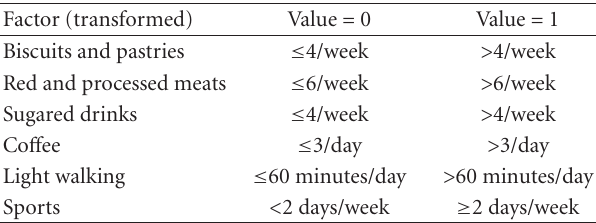
Table 4: Cuto ff points identified by the automatic lineal regression model.